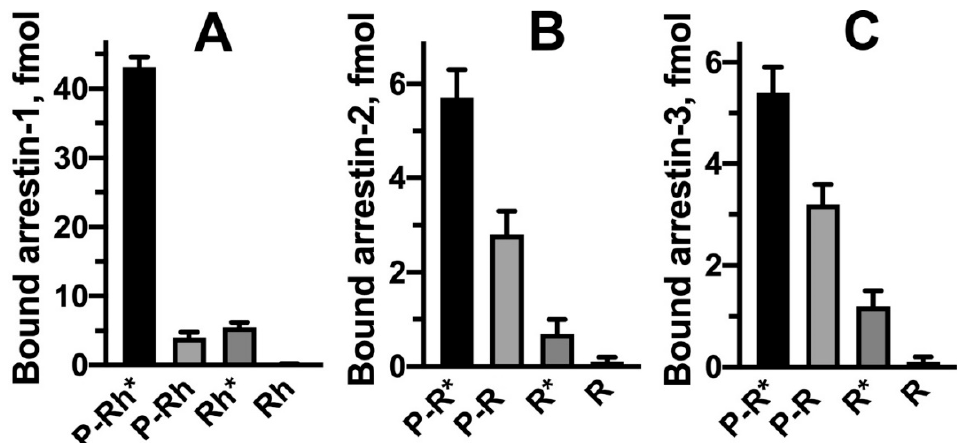
Figure 4. Receptor functional form selectivity of arrestins. ( A ) Binding of arrestin-1 to the four functional forms of rhodopsin. Note the ~10-fold higher binding to P-Rh* than to inactive P-Rh or unphosphorylated active Rh*. ( B , C ). Binding of arrestin-2 ( B ) and arrestin-3 ( C ) to four functional forms of the β 2-adrenergic receptor. Note only an ~2-fold binding differential between the active and inactive phosphorylated receptor. In all cases, arrestins do not bind inactive unphosphorylated receptors. Binding data from [49].